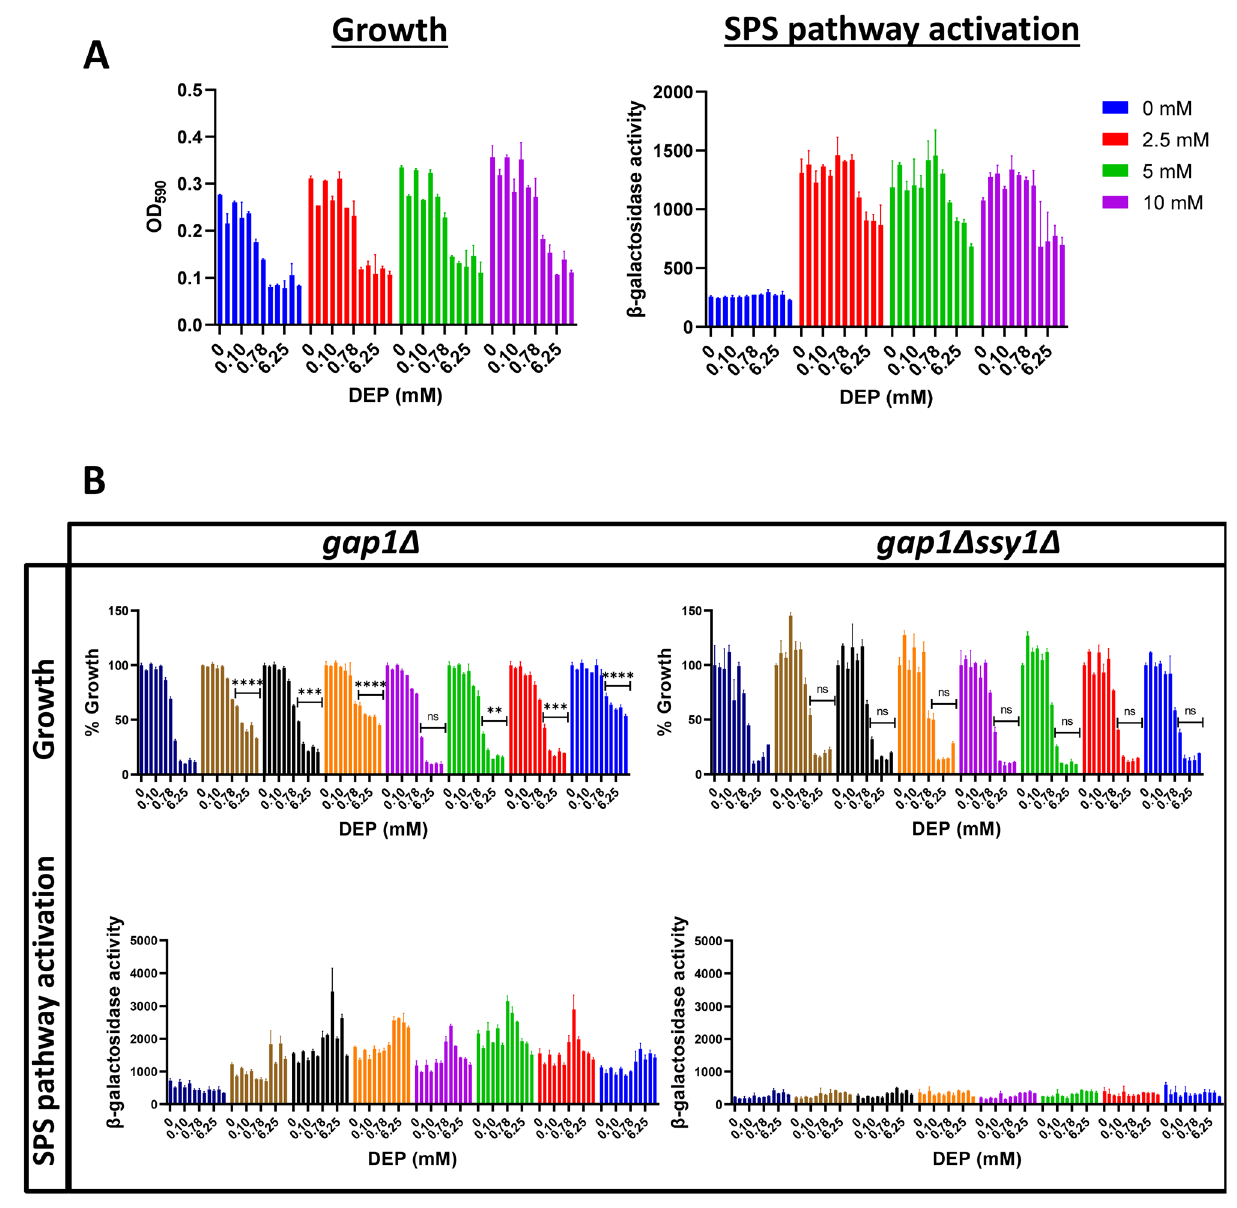
Figure 5. DEP does not affect the activation of the SPS signalling pathway. ( A ) OD 600 and β-galactosidase activity in gap1Δ (Σ1278b background) with DEP at different phenylalanine concentrations (0, 2.5, 5 and 10 mM). Error bars indicate standard deviation ( N = 2). Two-fold serial dilution of DEP (maximum concentration at 25 mM) was used. ( B ) Comparison of normalized growth and β-galactosidase activity in gap1Δ and gap1Δ ssy1Δ (Σ1278b background) with and without individual amino acids (5 mM) methionine (M), isoleucine (I), tyrosine (Y), threonine (T), tryptophan (W), leucine (L) and phenylalanine (F) at a series of DEP concentrations. Error bars indicate standard deviation ( N = 2). Two-fold serial dilution of DEP (maximum concentration at 25 mM) was used. (One-tailed paired t -test: **** P ≤ 0.0001, *** P ≤ 0.001, ** P ≤ 0.01, * P ≤ 0.05 and ns: P >